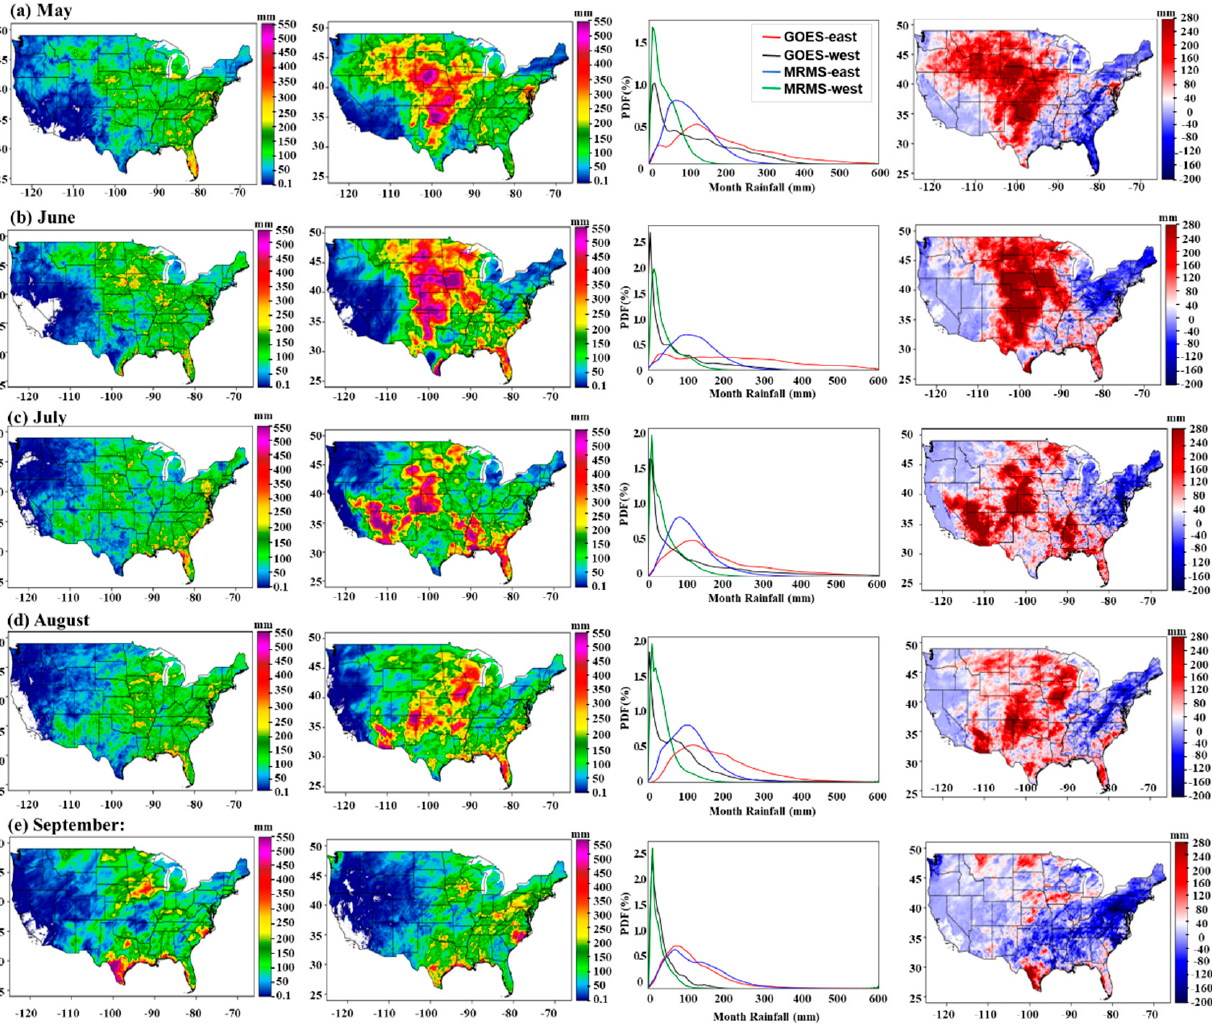
Figure 5. The comparison of monthly rainfall accumulations from the GOES-16 QPE and GC-MRMS during the warm season (May to September) in 2018. From top to bottom, the rows represent different months. From left to right, the columns are: GC-MRMS, GOES-16 QPE, PDF of monthly total rainfall, and the difference between GOES-16 QPE and GC-MRMS (the former minus the latter).